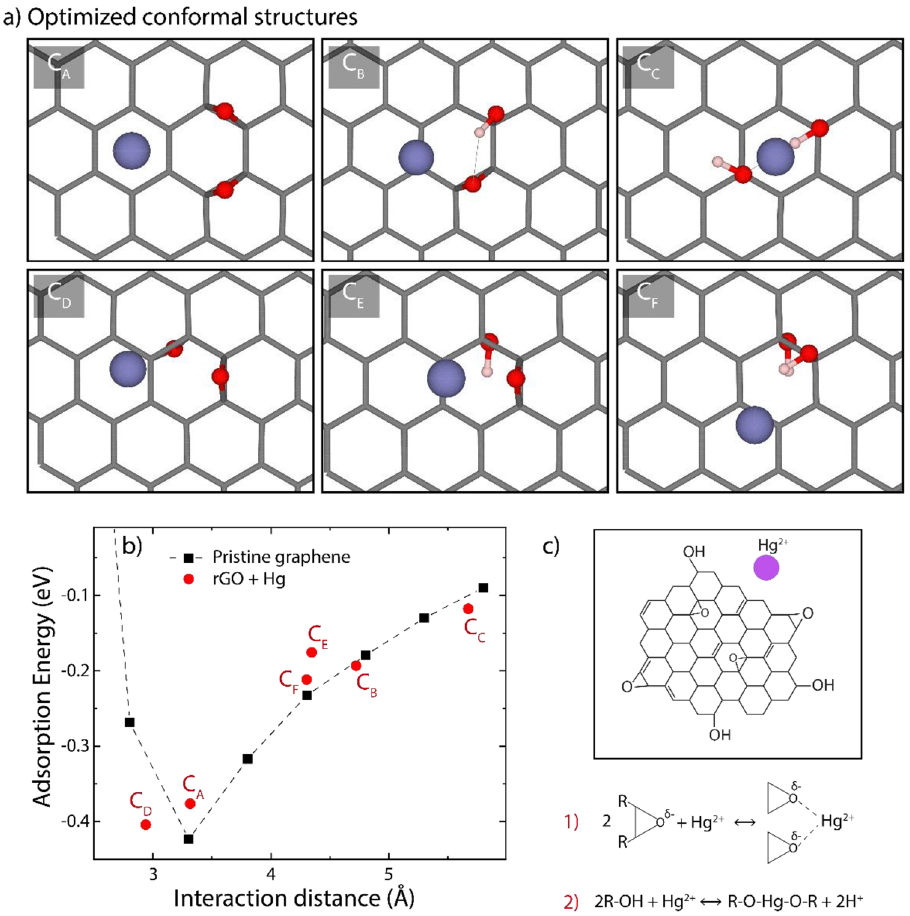
Figure 6. DFT computations. ( a ) Optimized rGO structures interacting with a single Hg atom, ( b ) Adsorption energy and interaction distance of the Hg atom as a function of the position of the oxygen-functional groups on the rGO surface, and ( c ) the proposed chemical reaction mechanism: 1 represents physisorption and 2 represents chemisorption. ( a ) was produced using the VMD software 56 , version 1.9.3, available at: https:// www. ks. uiuc. edu/ Resea rch/